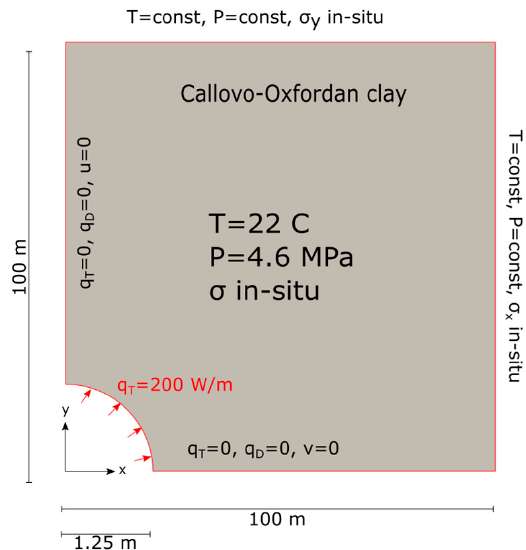
Figure 3. Model domain, boundary conditions, and study points.